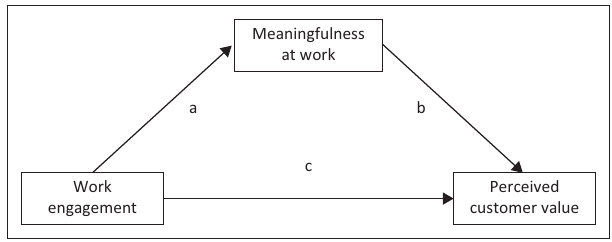
FIGURE 1 : Proposed mediation model, work engagement, meaningfulness at work and perceived customer